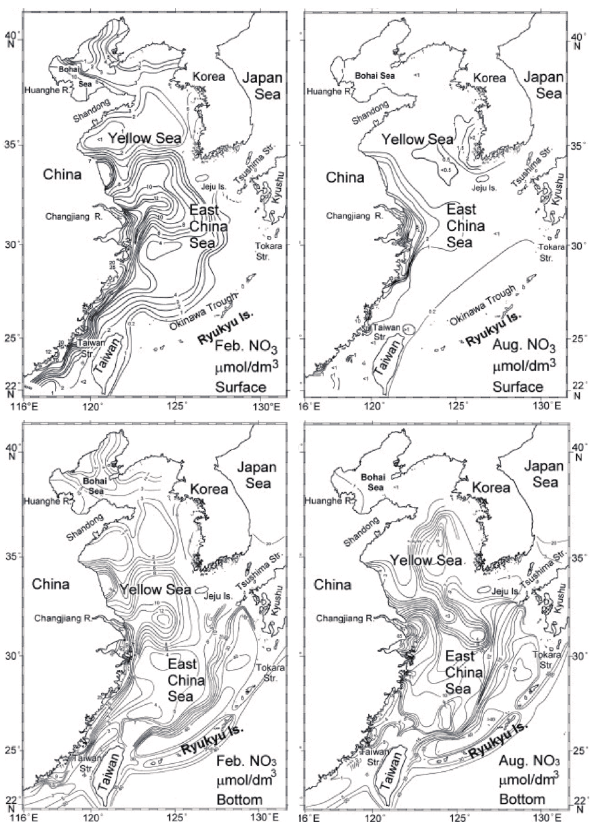
Fig.4 Fig. 4. Surface and bottom nitrate concentrations in February and August, taken from Chen